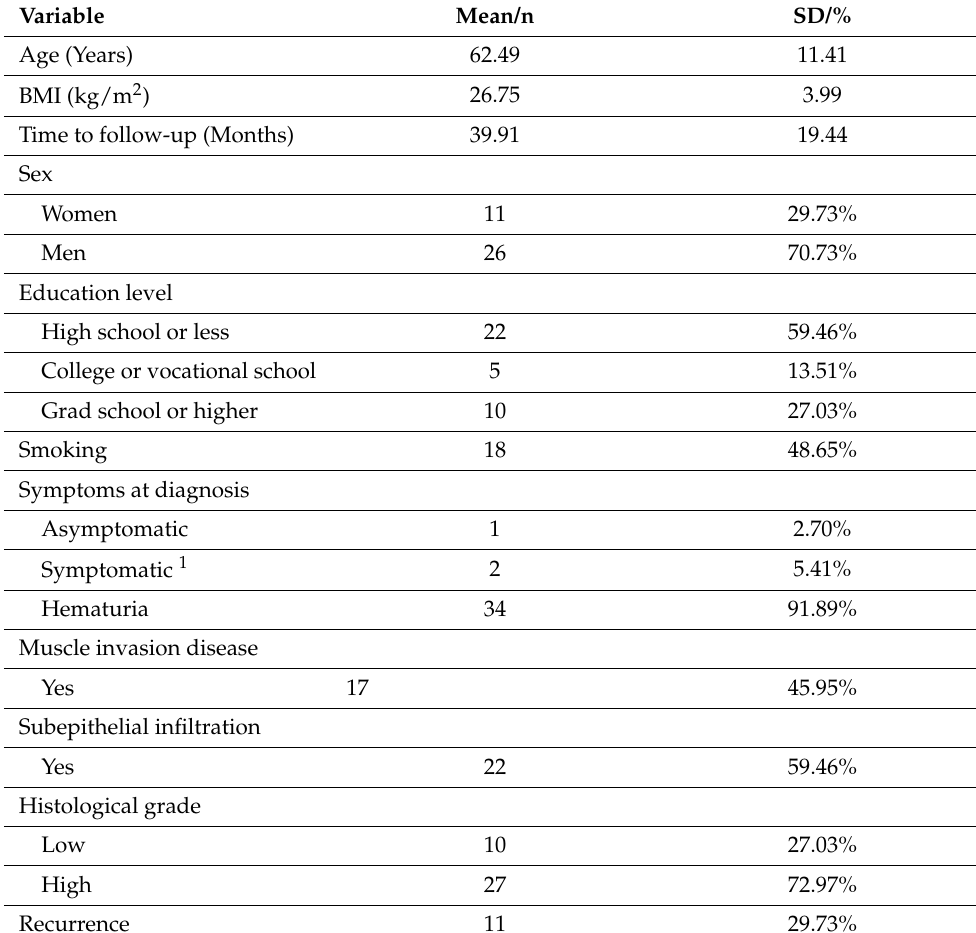
Table 1. Demographic characteristics of patients with bladder cancer treated at the INCan between 2012 and 2021 (N =